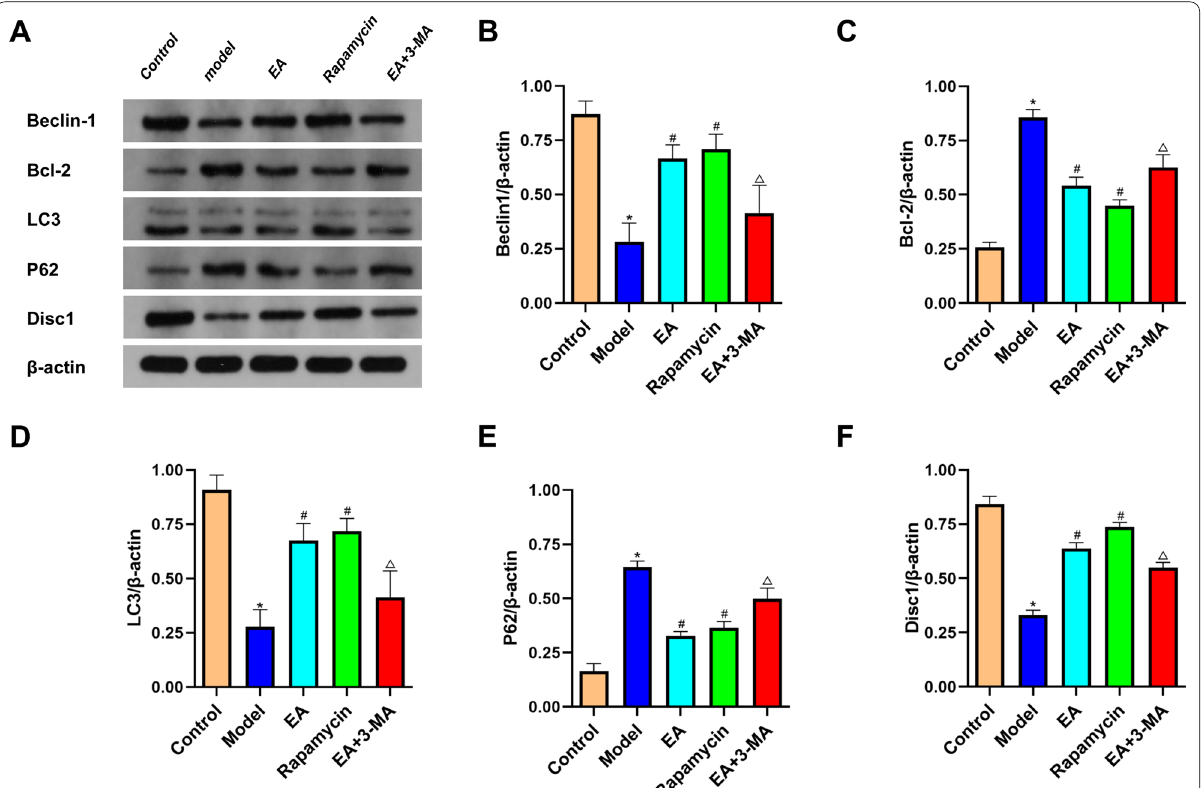
Fig. 8 Effect of EA on autophagy related proteins in diabetic rats. a Protein bands of Beclin1, Bcl-2, LC3-II/I, P62, Disc1 and β-actin. b Quantitative analysis of Beclin1 relative expression. c Quantitative analysis of Bcl-2 relative expression. d Quantitative analysis of LC3-II/I relative expression. e Quantitative analysis of P62 relative expression. f Quantitative analysis of Disc1 relative expression. Data are expressed as mean the mean ( n 8 in each group). * p < 0.05 versus control group; # p < 0.05 versus model group; △ p < 0.05 versus EA group =